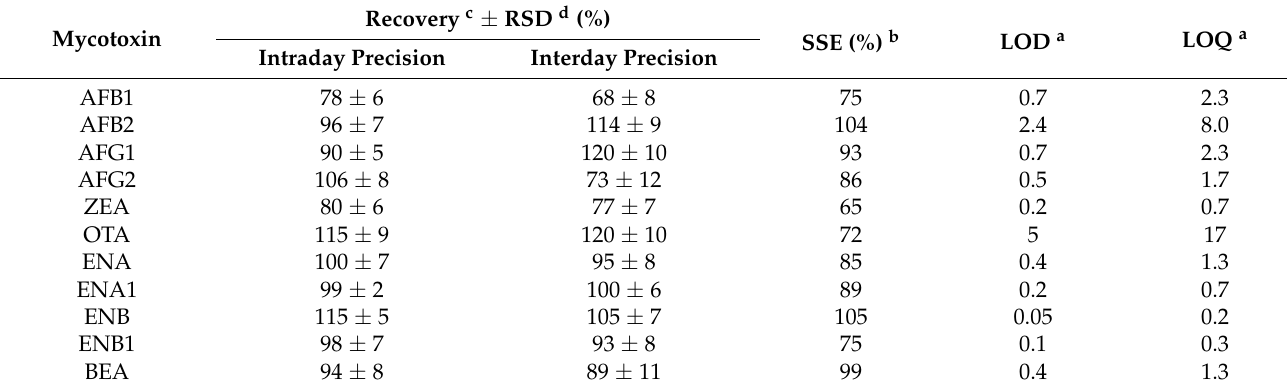
Table 2. Analytical parameters for method validation.